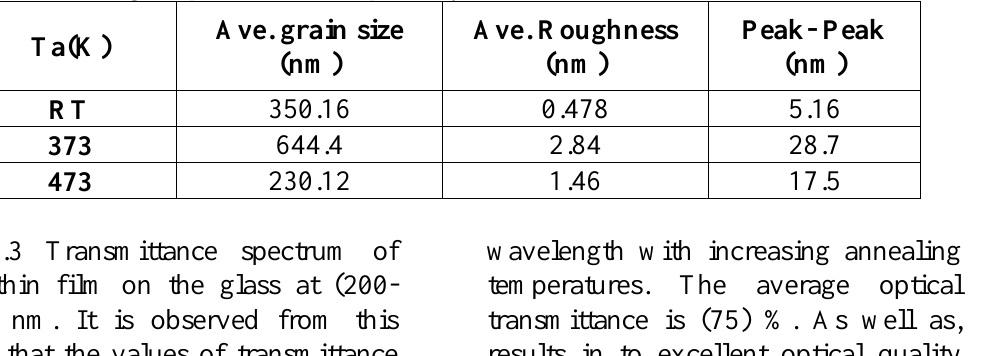
Fig. 2: 3D-AFM images for ZnO thin films at RT and different annealing temperatures. Table 2: Average grain size, average roughness and Peak- Peak for ZnO thin films with different annealing temperatures (as deposited, 373 and 473) K.